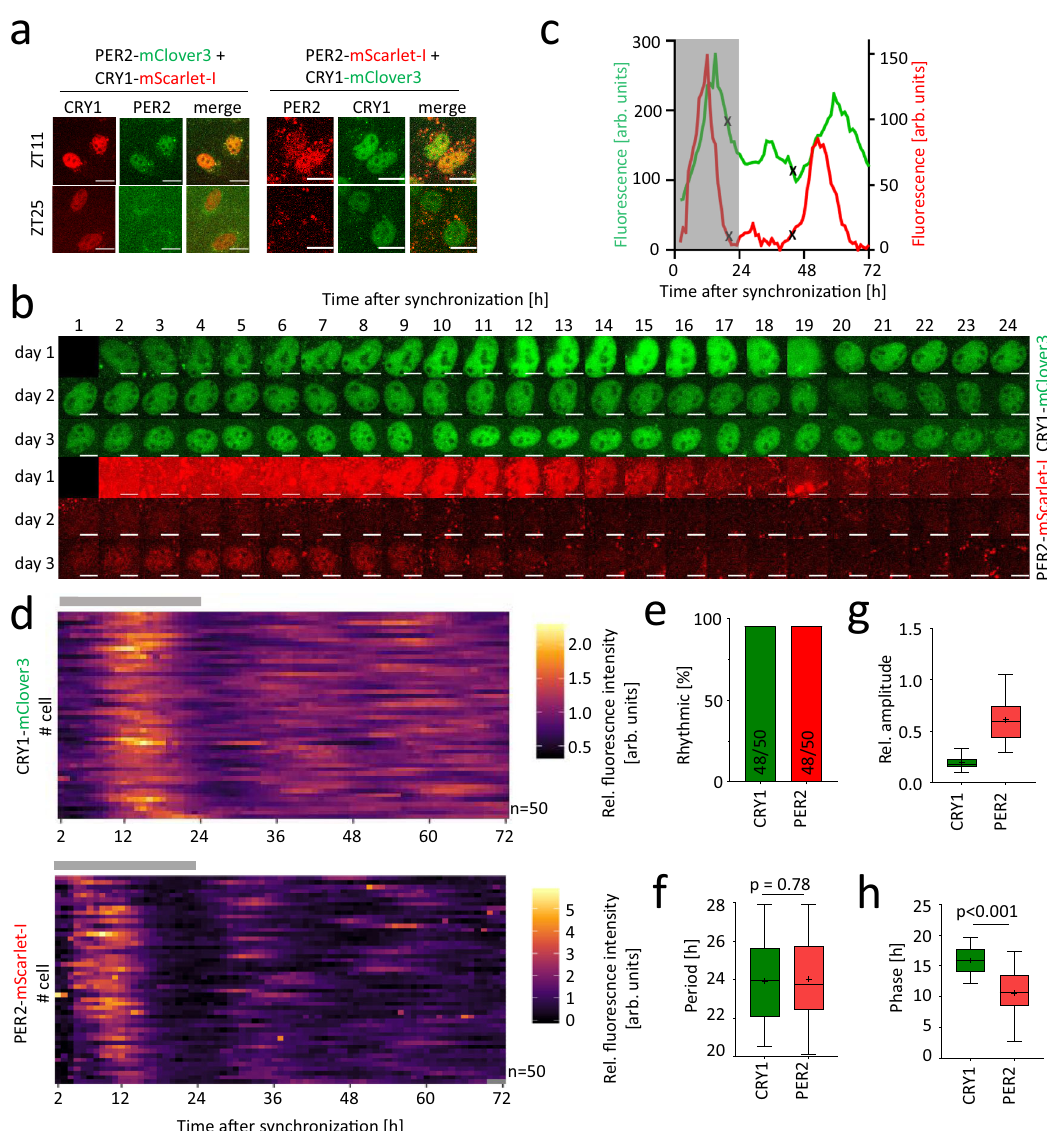
Fig. 3 Simultaneous visualization of PER2- and CRY1-fusion protein oscillations in double knock-in cells. a PER2- and CRY1-fusion protein oscillation in individual double knock-in cells. Fluorescence images of selected double-knock in clones at different times after synchronization. b Montage of bicolor fl uorescence microscopy images of an individual U-2 OS double-knock-in cell ’ s nucleus over the course of 3 days after synchronization. c Mean nuclear fl uorescence intensity (background-subtracted) quanti fi ed from ( b ). Cell division marked by (x). d Time series of normalized mean nuclear fl uorescence in individual double knock-in cells. e Percentage of signi fi cantly rhythmic time series from d (n = individual cells as stated in f ). f – h Extracted rhythm parameters of signi fi cantly rhythmic single-cell time series from d . p-values: Mann-Whitney-U test, two-sided, for h , p-value = 2*10 − 15 . Boxplots: box: interquartile range, center: median, whiskers: minimum to maximum, mean is marked by ( + ). Scale bar: 10 µ m. The fi rst 24 hours after synchronization (possible acute response to dexamethasone) are highlighted by a gray box ( c ) or bar ( d ). ZT = zeitgeber time. Source data are provided as a Source Data fi